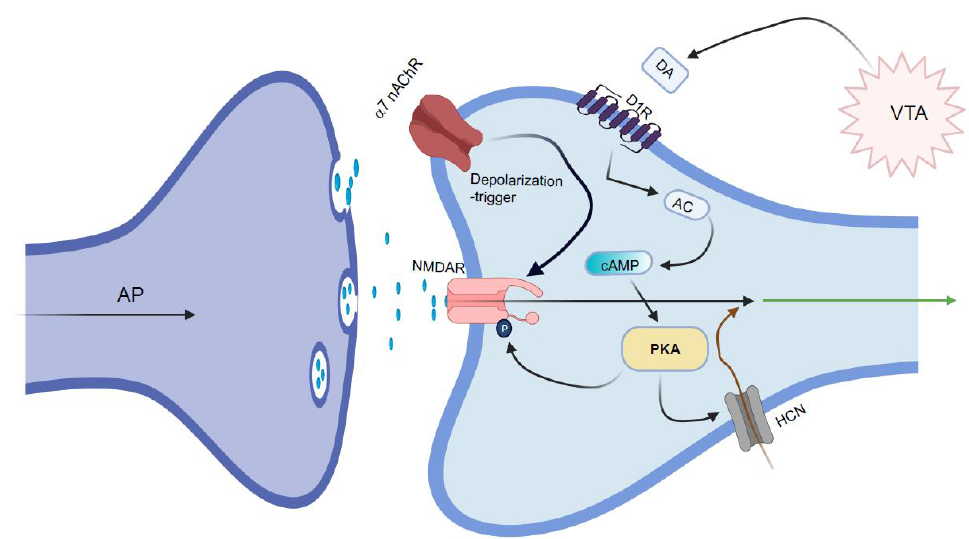
Figure 5. Schematic illustration of the synaptic connection between glutamatergic pyramidal cells in layer III of the dorsolateral prefrontal cortex. Glutamatergic pyramidal cells form synapses between axon terminals and dendritic spines. NMDARs expressed on the postsynaptic membrane are triggered by the stimulation of α7 nAChRs that are co-expressed in postsynaptic cells. D 1 Rs are also expressed on postsynaptic dendritic spines, where they often co-localize with hyperpolarization-activated cyclic nucleotide (HCN) channels. HCN channels are activated by cAMP-PKA signaling, leading to rhythmic depolarization of the cells. There is optimism that synaptic transmission might be possible when signaling NMDAR is harmonized with stimulatory effects via D 1 R. Adapted from Reference [97]. AC, adenylyl cyclase; AP, action potential. Figures created with https://biorender.com/ (accessed on 15 April 2021).